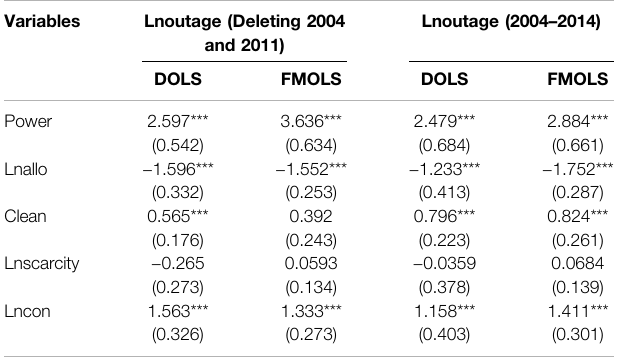
TABLE 6 | Robustness tests (using the CCR model) Variables